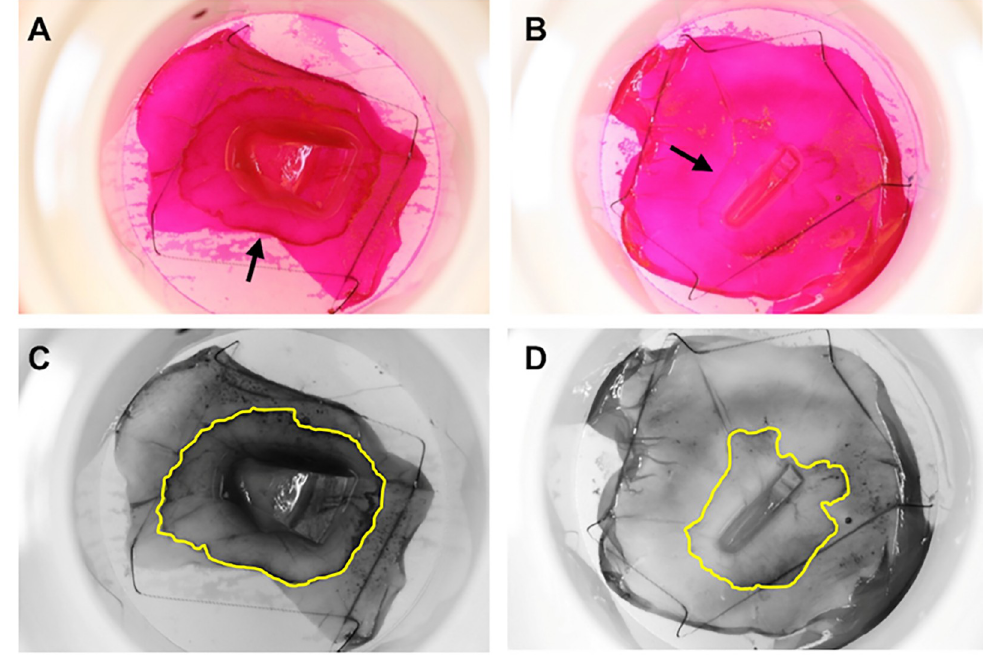
Fig 3. Rhodamine staining of small and large explants. Rhodamine staining of cultured limbal epithelial cells from large (A and C) and small (B and D) explants. A, and B are color photographs of the cultures, and C and D represent the same photographs processed by ImageJ. The corneoscleral explants can be seen in the center of the cultures. The leading edges of cultured limbal epithelial cells are indicated by arrows (A and B). The total areas of the cultured limbal epithelial sheets including the explant areas are highlighted in yellow (C and